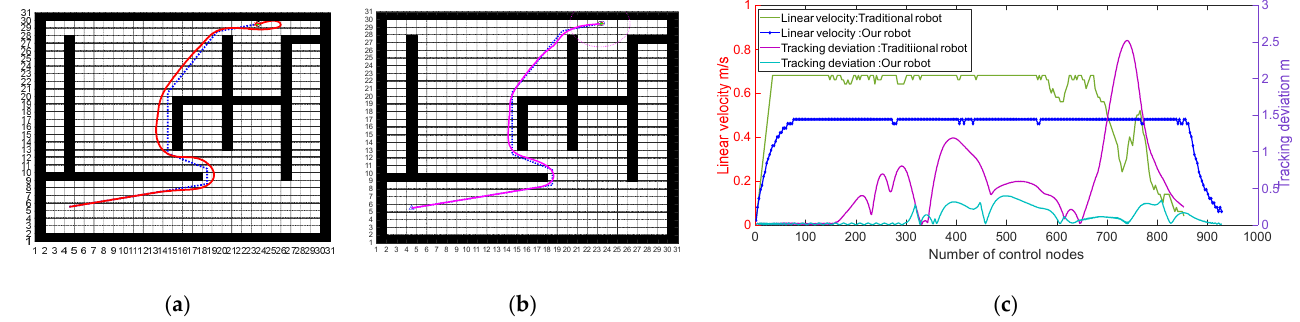
Figure 16. Map 3’s experimental results. ( a ) Traditional robot. ( b ) Our robot. ( c ) Two-coordinate plot of linear velocity and tracking deviation.